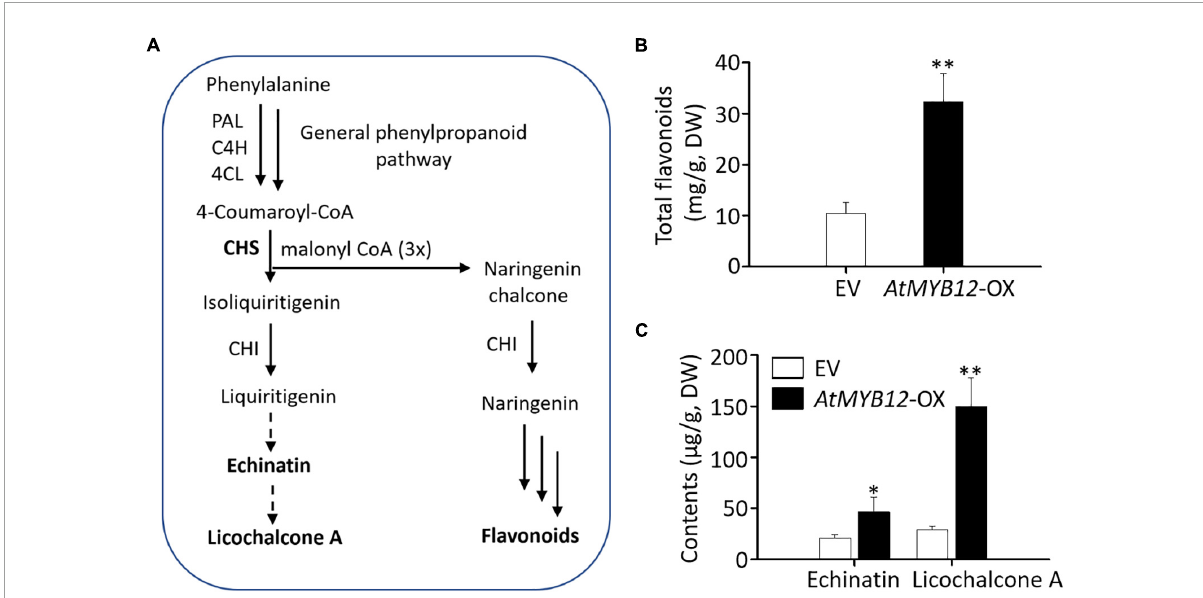
FIGURE1 Proposed biosynthetic pathway of licorice chalcones and measurement of metabolites in empty vector (EV) control and AtMYB12 -OX hairy roots of G. inflata . (A) A simplified, schematic diagram of the proposed licorice chalcone and general flavonoid biosynthetic pathway. PAL, phe ammonia lyase; C4H, cinnamate 4-hydroxylase; 4CL, 4-coumarate; CoA ligase; CHS, chalcone synthase; CHI, chalcone isomerase. Solid arrows indicate known enzymes; dotted arrows indicate pathway enzymes are not known. (B,C) Echinatin and licochalcone A contents on dry weight basis. Data are presented as the mean ± SD ( n = 3). Asterisks indicate statistically significant differences compared with EV lines ( ∗ p < 0.05, ∗∗ p < 0.01, Student’s t -test). Total flavonoids based on dry weight